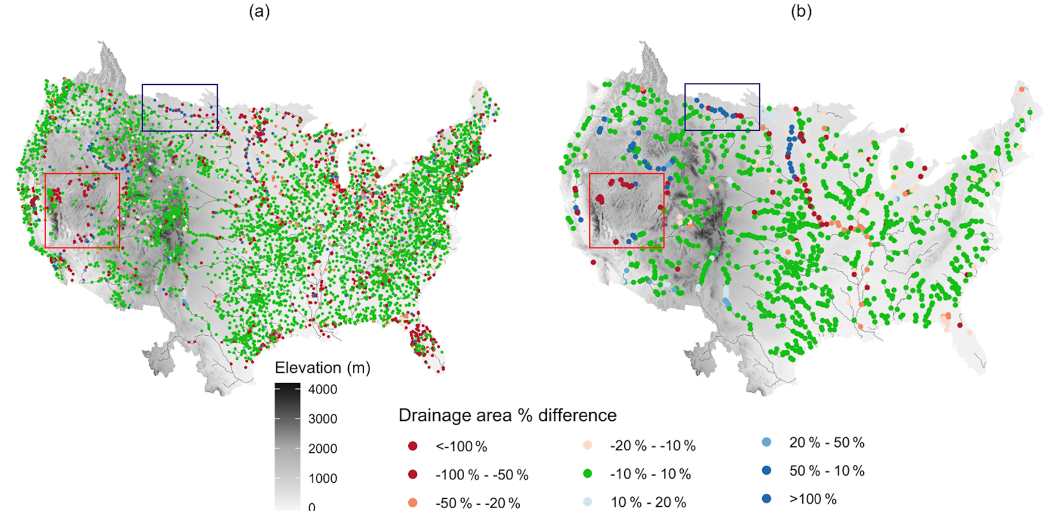
Figure 4. Drainage area comparison between processed with initial fifth-order stream network and USGS gage measurements. (a) All gages for comparison; (b) gages with drainage area over 5000km 2